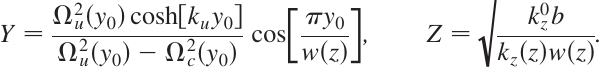
ffiffiffiffiffiffiffiffiffiffiffiffiffiffiffiffiffiffiffiffi